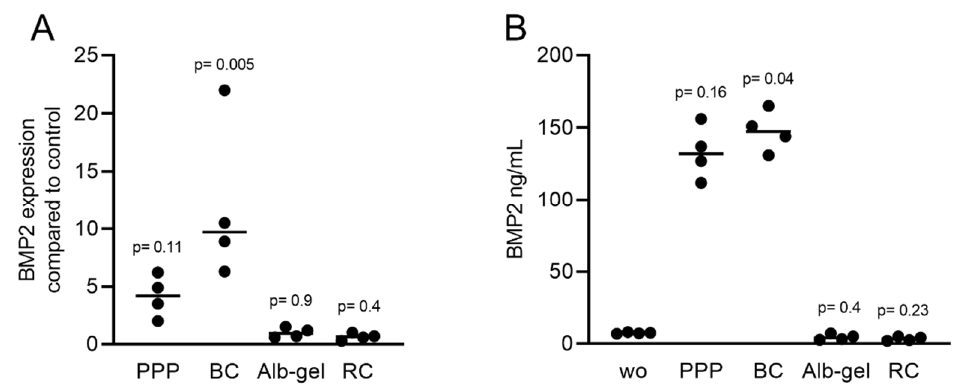
Figure 8. RT-PCR and immunoassays triggered by liquid PRF confirmed the expression of BMP2 . Gingival fibroblasts were exposed to PPP, BC, Alb-gel, and RC fractions. ( A ) PCR analysis for BMP2 is indicated; ( B ) The levels of BMP2 in the supernatant of fibroblasts in the presence of PPP and BC are presented as ng/mL. n = 4. Statistical analysis was based on the Kruskal–Wallis test for multiple comparisons. ”wo” indicates without and represents unstimulated cells.